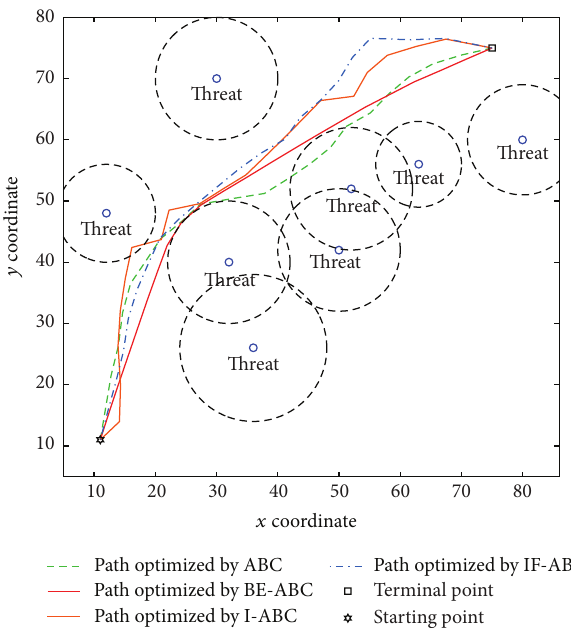
Figure 3: Comparative path planning results optimized by different ABC relevant algorithms in Case 1 ( 𝐷 = 20 ).